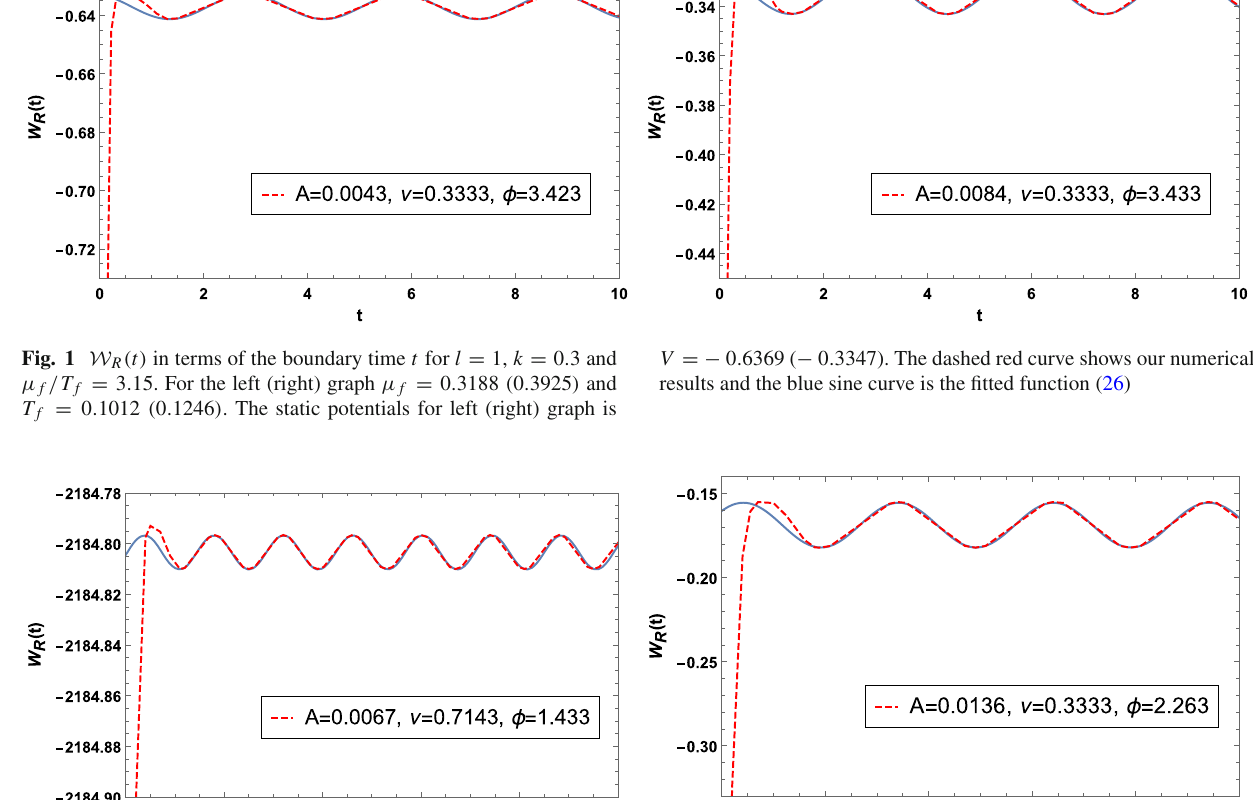
V ( l ) = − 2184 . 8 ( − 0 . 1686) for left (right) graph. The dashed red curve shows our numerical results and the blue sine curve is the fitted function (26)